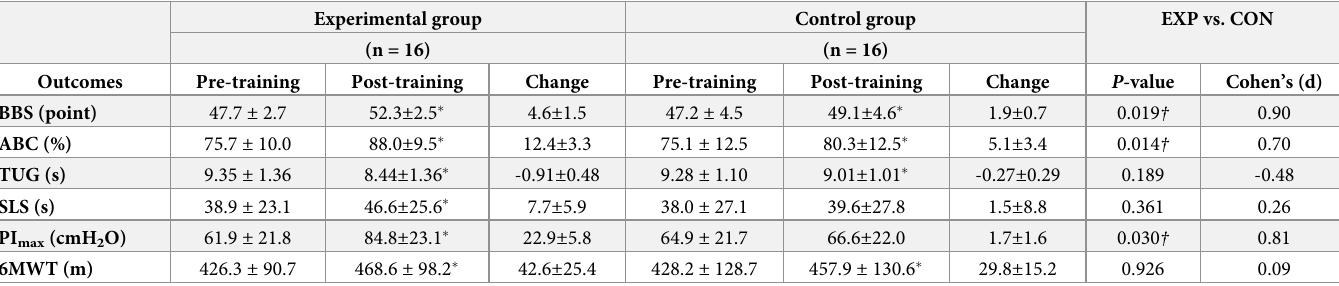
Table 3. Pre and post-training